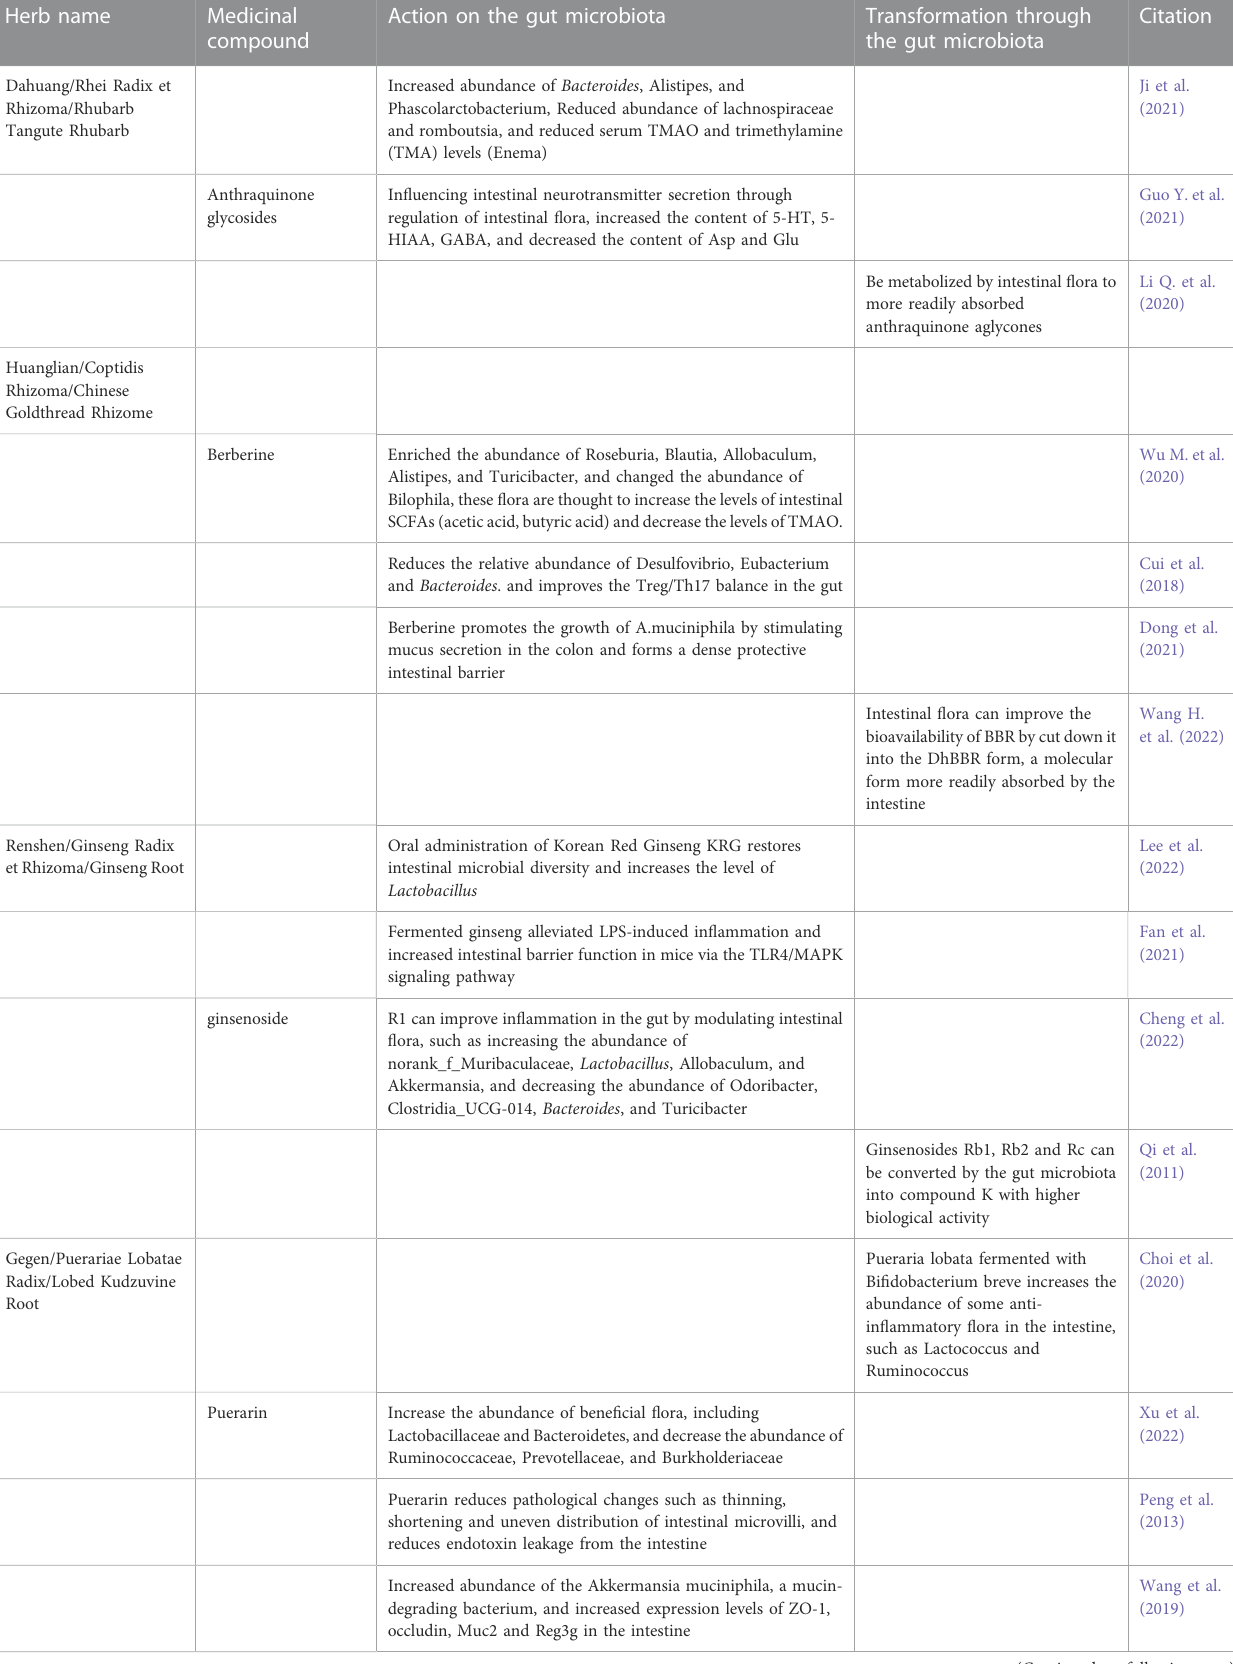
TABLE 2 Studies on the regulation of gut microbiota by Chinese medicinal